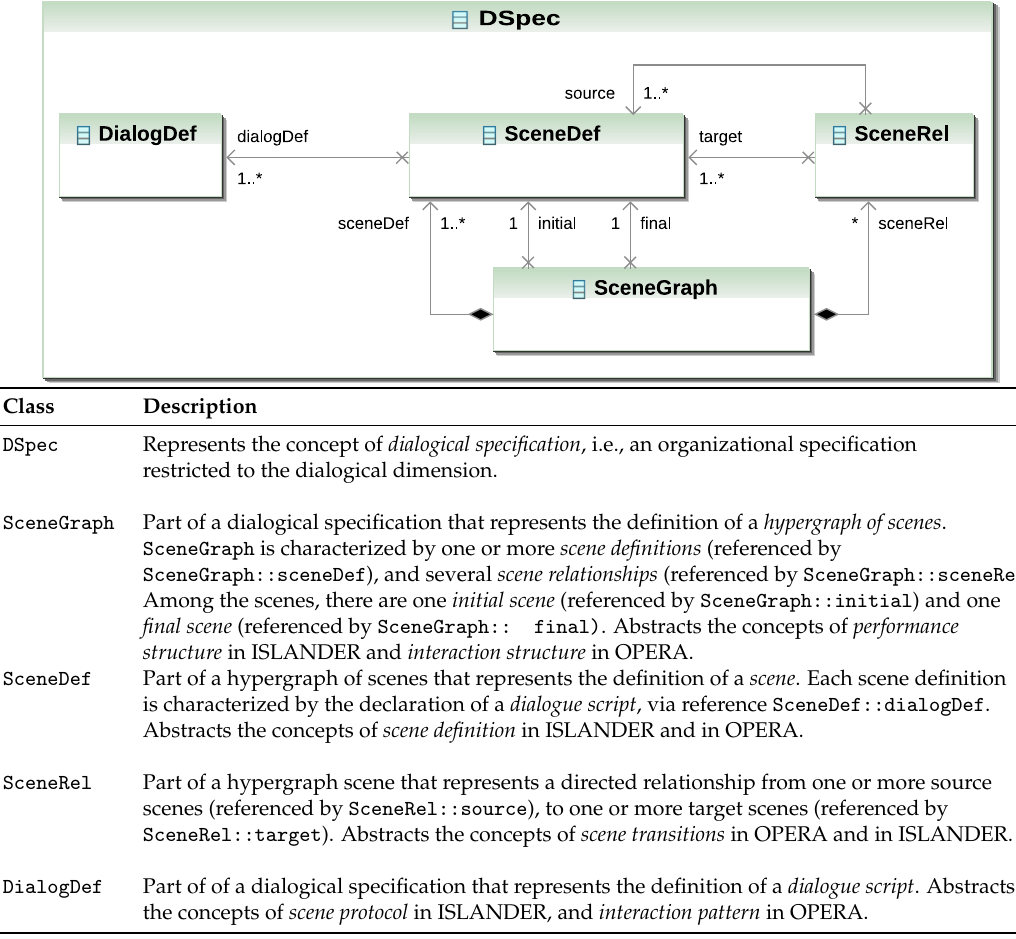
Table 5. Dialogical specification pattern: Classes